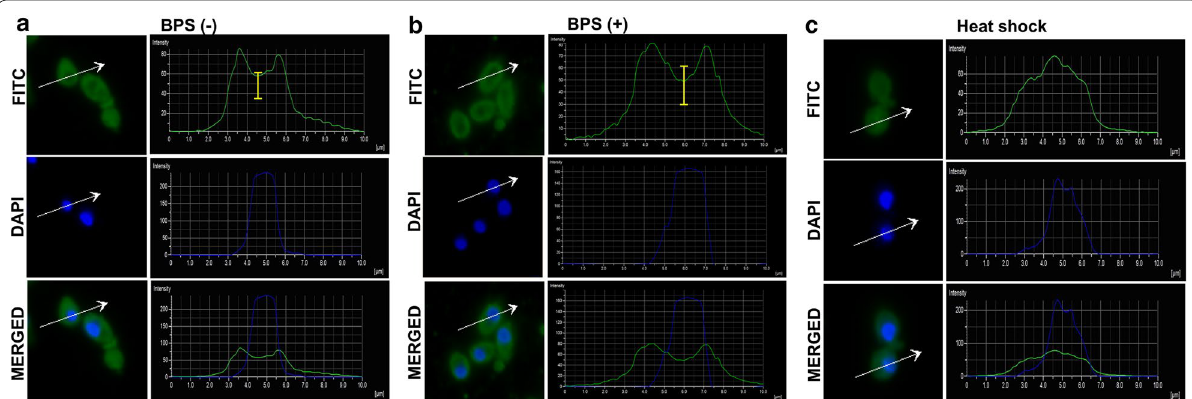
Fig. 7 Analysis of cellular localization of Hsf1—Microscopy images of Hsf1 cellular localization in a wildtype [BPS ( ( )] cells and c heat shock treated cells. The fluorescent images are shown alongside quantified intensity plot. The topmost panel in each section + represents staining with primary antibody (anti-Hsf1 coupled with secondary antibody labeled with FITC visualized as green fluorescence). The middle panel represents nuclear staining with DAPI. The bottom panel is the merged Fig. The fluorescence intensity of the selected transversal section of the cell (arrow line) was quantified and represented as intensity plot, where the length and direction are expressed as distance on the x-axis. Two peaks in the intensity plot in a and b corresponding to cytoplasmic localization of Hsf1 was observed. The dip in fluorescence depicting Hsf1 concentration in the nucleus in a and b panel is due to the lesser amount of Hsf1 in the nucleus as compared to the cytoplasm. The dip is more prominent in case of BPS ( ) cells. The sharp peak in case of heat shock c corresponds to increased nuclear localization of Hsf1 upon heat + shock